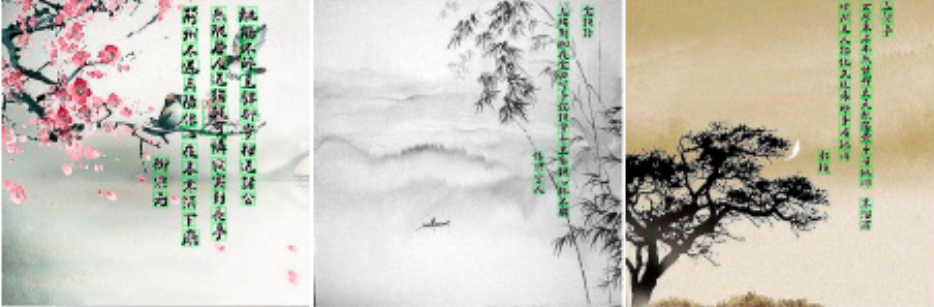
Figure 10. Pre-training detection